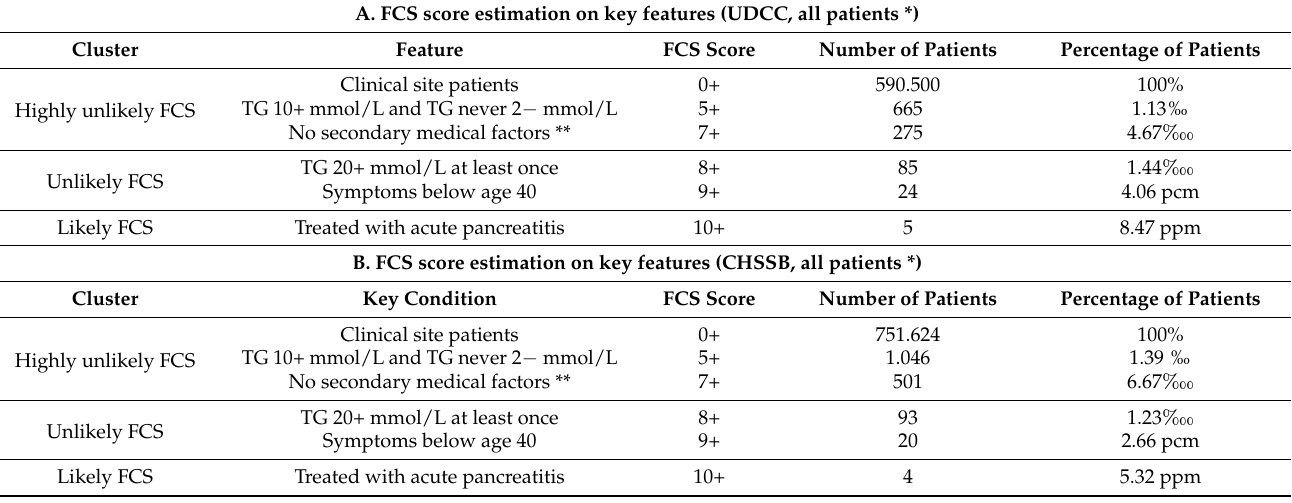
Table 4. Familial chylomicronemia (FCS) score estimation on key